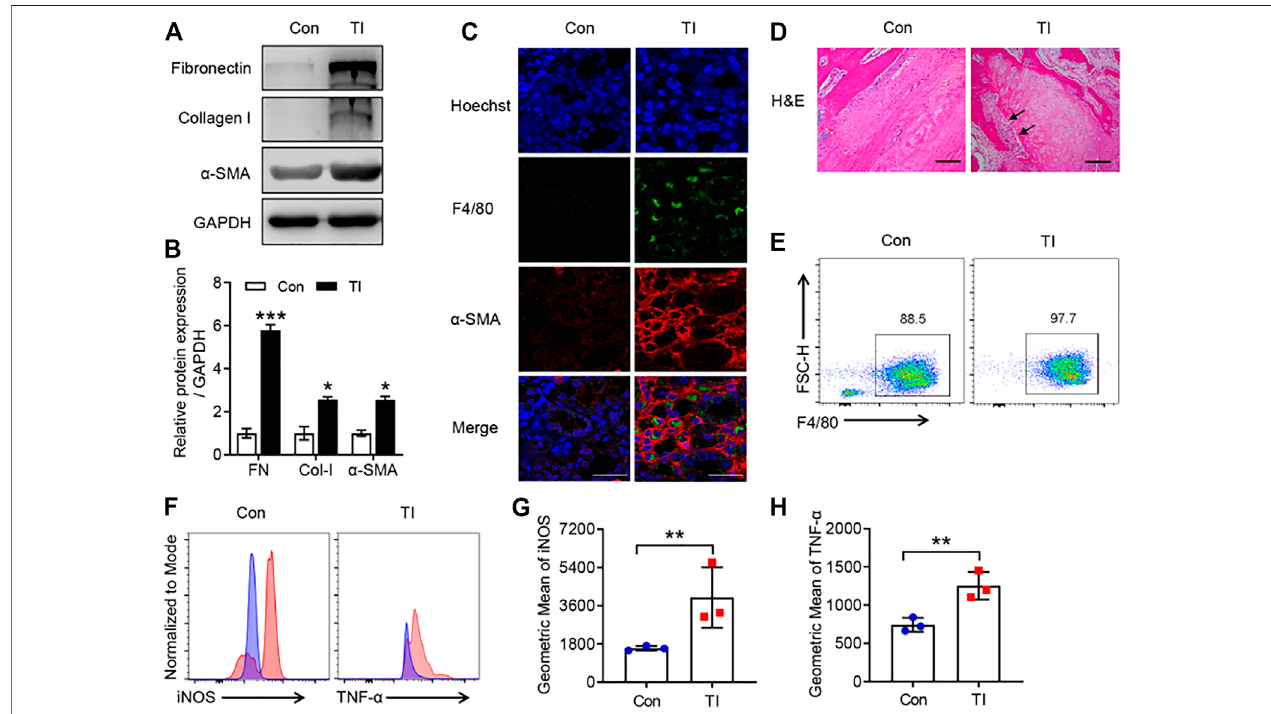
FIGURE 1 | The increased peritendinous fi brosis and macrophage in fi ltration in TI. (A) Western blot analysis of FN, Col-I, and α -SMA in tendon from control (Con) and TI mice. (B) Quantitative analysis of FN, Col-I, and α -SMA in A . (C) Confocal analysis of F4/80 and α -SMA in the tendon section from Con and TI mice. Scale bar = 20 μ m. (D) H&E staining in the tendon section from Con and TI mice. Scale bar = 200 μ m. (E) Flow cytometric analysis (FACS) of M-CSF-induced macrophages (F4/80 + ) from Con and TI groups. (F) FACS representative analysis of iNOS and TNF- α . (G,H) Quantitative analysis of geometric mean of iNOS and TNF- α in E. Data are presented as the mean ± SEM ( n = 3) (B,G,H) . * p < 0.05, ** p < 0.01, *** p <